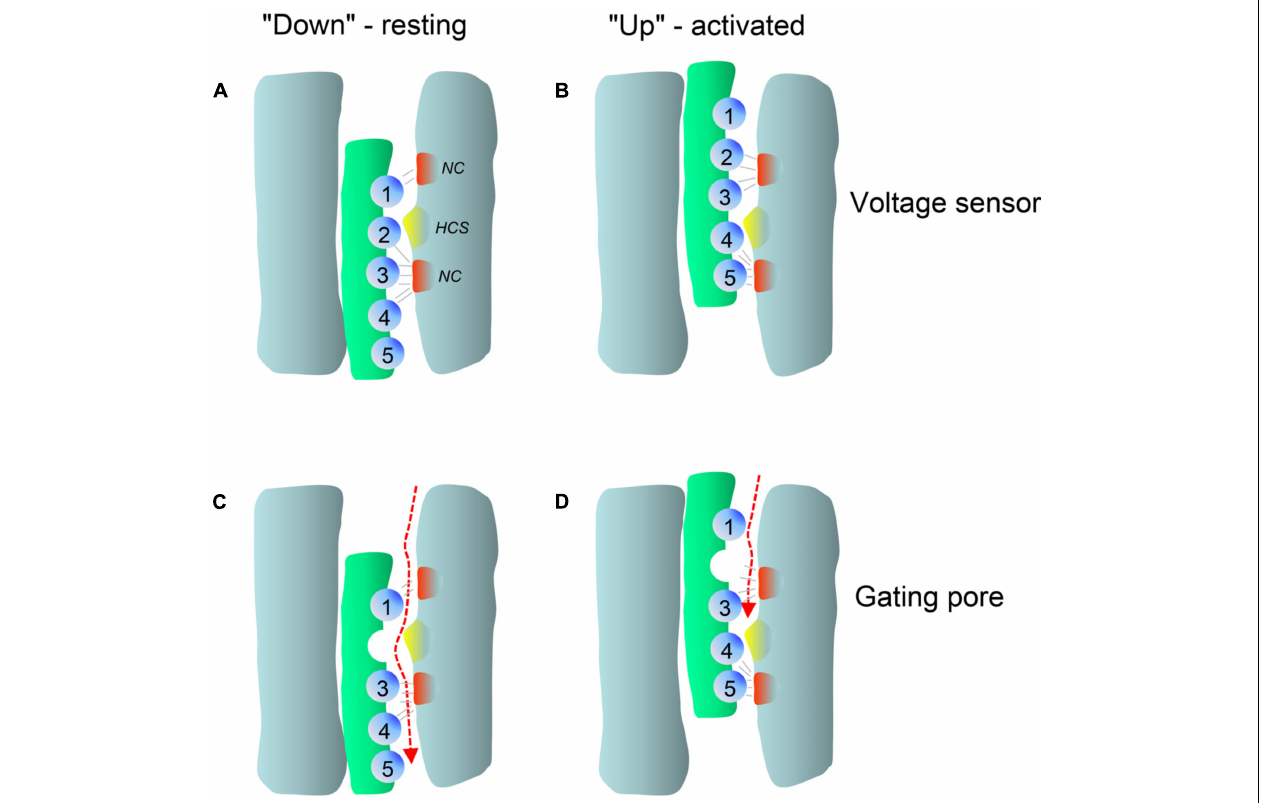
FIGURE 5 | Membrane potential dependent conformations of the voltage-sensor allow pathogenic gating pore current. Simplified scheme illustrating the membrane potential dependent conformations of a single voltage-sensor and the effects of a mutation in gating charge R2. Membrane-spanning S4 helices are shown in green, positively charged residues (mostly arginines spaced at three residue intervals) as blue spheres. Clusters of extracellular and intracellular negative counter-charges (NC) forming ion pair interactions with the gating charges are shown in red. The hydrophobic constriction site is indicated in yellow (HCS). (A) In the resting state, the positively charged S4 helix is pulled inside by the negative resting potential ( A , S4 “down”). (B) Upon depolarization, the S4 segment moves outward according to a sliding-helix model (Catterall et al., 2020; B , S4 “up”), and transports positive gating charges through the HCS. Inside and outside the HCS the arginine side chains are stabilized by forming ion pairs with negative charges within the VSD (gray lines). Upon S4 movement the ion pair partners are exchanged and the large arginine side chains seal the VSD and prevent formation of a water filled space through which ions can flow (Catterall et al., 2020). Replacement of a positive gating charge by a smaller or hydrophilic residue can disrupt this seal as exemplified here for a neutralizing mutation in R2 (C) . This position of the mutation permits an inward gating-pore current during the hyperpolarized “down”-state of the S4 helix at negative voltages but not during the depolarized “up”-state at positive voltages (D) . In contrast, mutations of one of the inner gating charges would permit gating pore current to flow in the activated but not the resting position of S4 (for X-ray structures of mutant voltage-gated Na + -channels see Jiang et al., 2018; Jiang D. et al.,